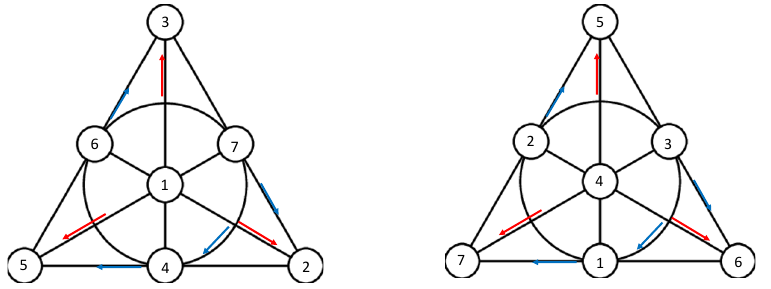
Figure 22 . The Fano plane at the left is for RCSC triads 126, 237, 341, 452, 563, 674, 715. At the right we show the oriented Fano plane for Cayley-Graves octonions, with 123, 145, 624, 653, 725, 734, 176 triads. It has the same orientation for all 7 lines as the one for RCSC. They are related to each other by the following relabeling from Cayley-Graves to RCSC: 5 to 3, 2 to 6, 7 to 5, 4 to 1, 3 to 7, 6 to 2, 1 to